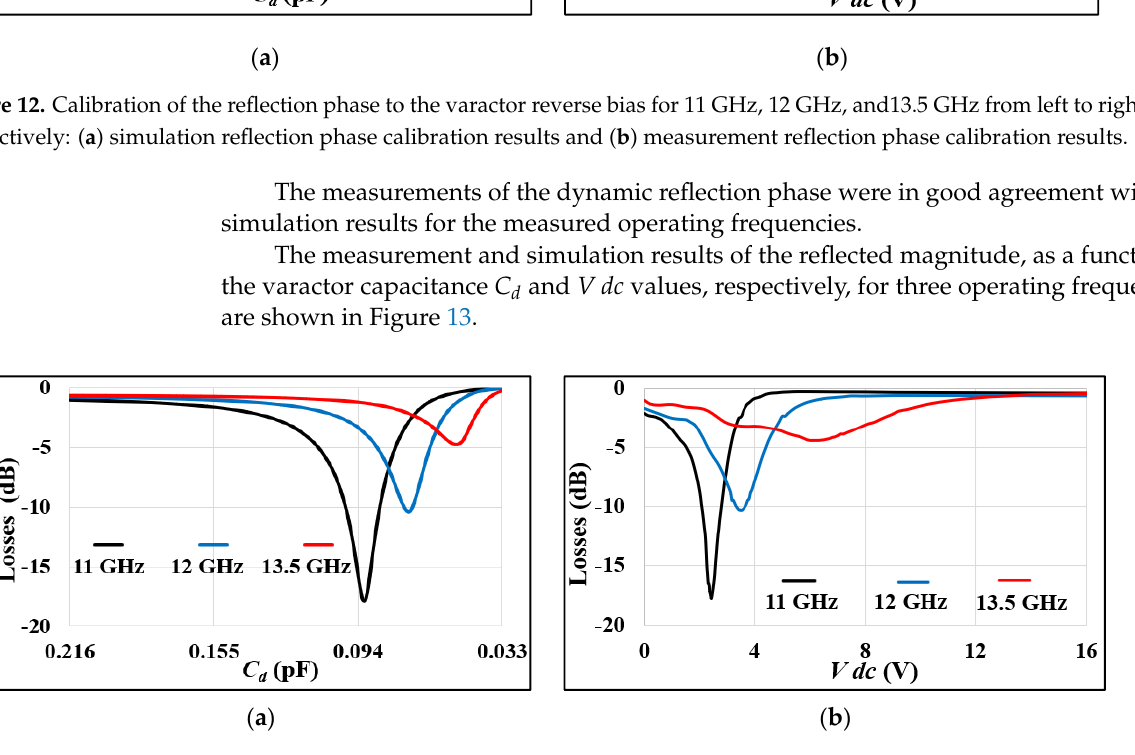
( a ) ( b ) ( c ) Figure 14. Reflection losses in the operating frequencies as a function of the reflection phase: ( a ) at 11 GHz, ( b ) at 12 GHz, and ( c ) at 13.5 GHz. The R S + R P values for each operating frequency were extracted by comparing the reflection’s absorption intensity between the simulations and the measurements (see Fig ‐ ure 11). These R S + R P values showed a good agreement in the dynamic phase profile be ‐ tween the measurements and simulations at all operating frequencies. 6. Beam Steering Results One possible application for this MS type is a reconfigurable steering reflector for radiation, which impinges the MS with polarization, as shown in Figures 2 and 5b. For each operating frequency, the phase calibration curve allows for extracting the appropri ‐ ate DC reverse biases for each column, which leads to the required phase difference, Δϕ , between the columns, thus creating the desired phase distribution on the MS reflector for